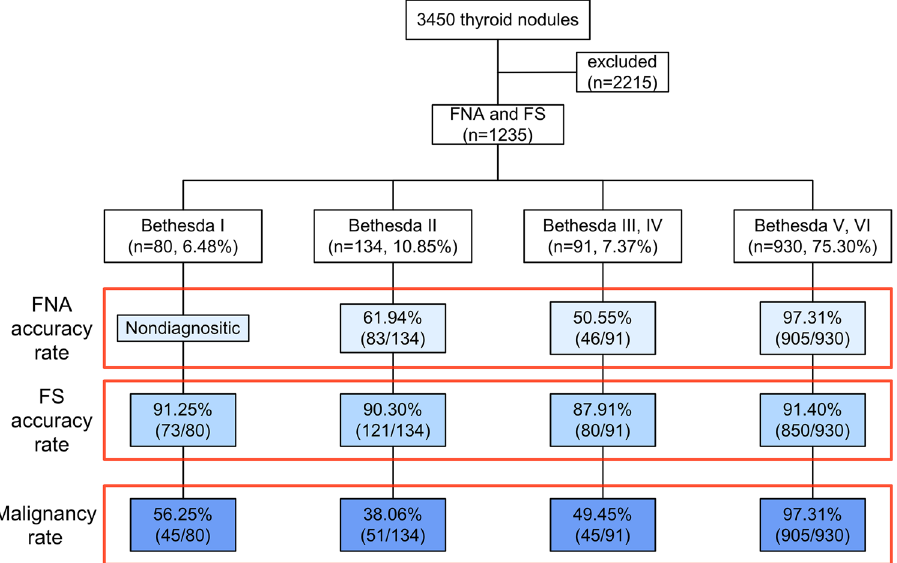
Figure 1. Diagnostic outcomes of 3,450 thyroid nodules. The final diagnoses of all nodules were confirmed by surgical pathology. FNA, fine needle aspiration; FS, frozen section.